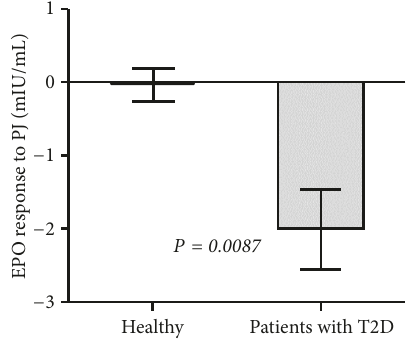
Figure 1: EPO responsetoPJ inT2D patients(n= 59)and in healthy individuals (n = 30). Values are given as the means ± S.E.M.